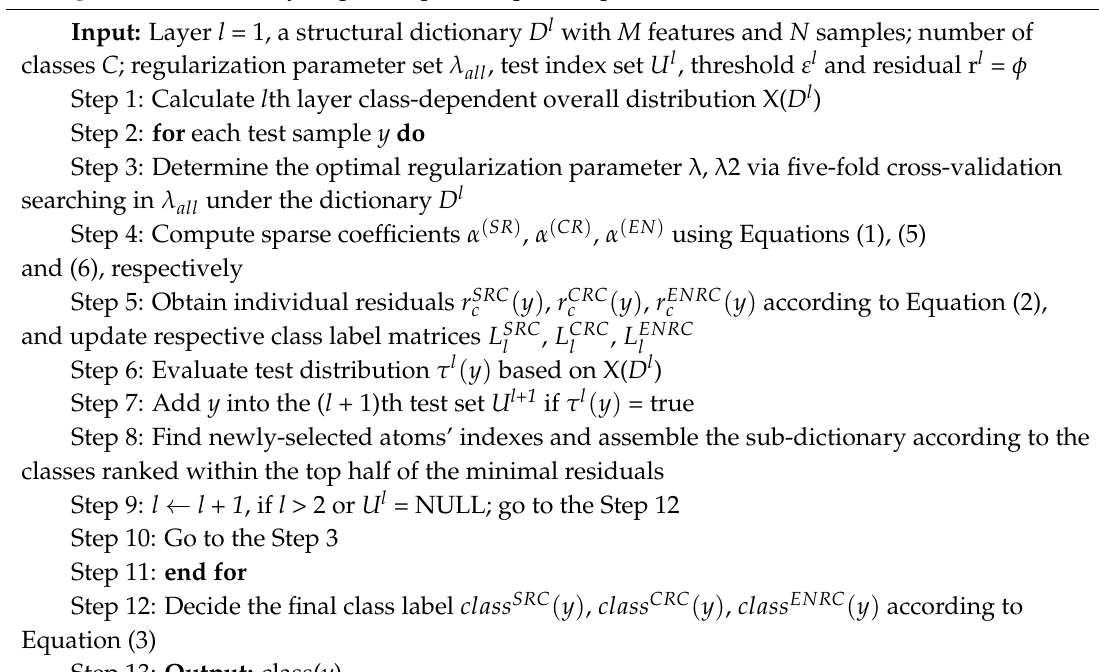
Algorithm 1. Multi-layer spatial-spectral sparse representation classifier.